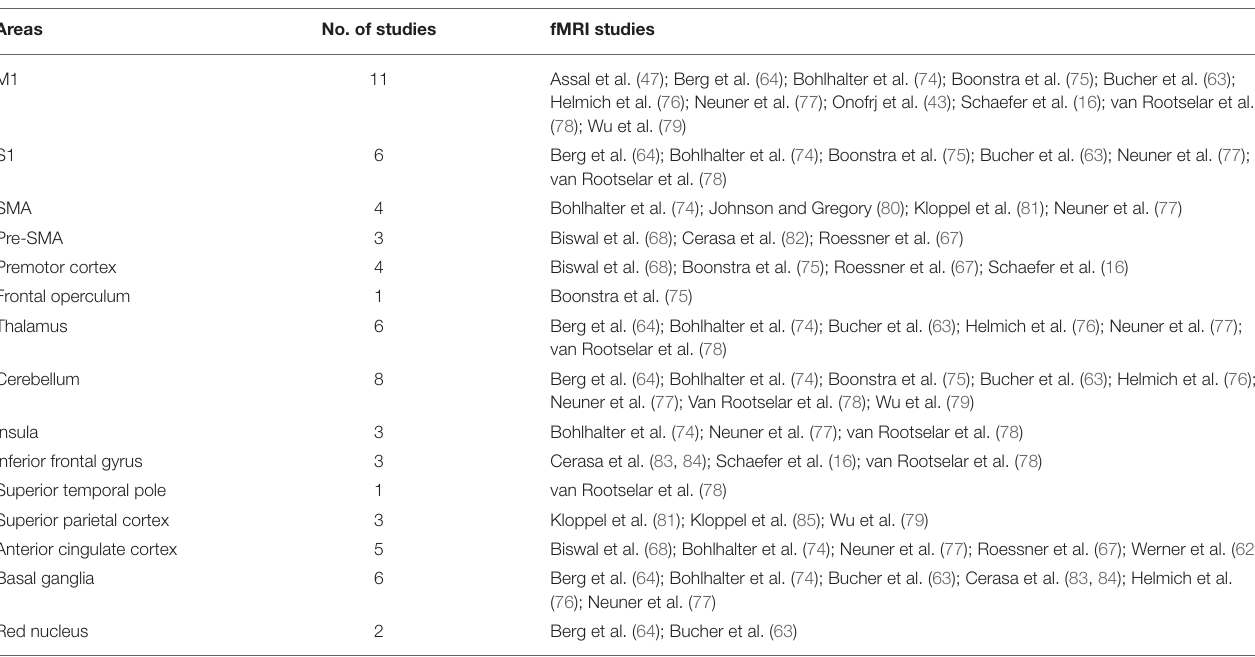
TABLE 3 | Activated areas during involuntary movements revealed by fMRI studies in patients with AL and other movement disorders.